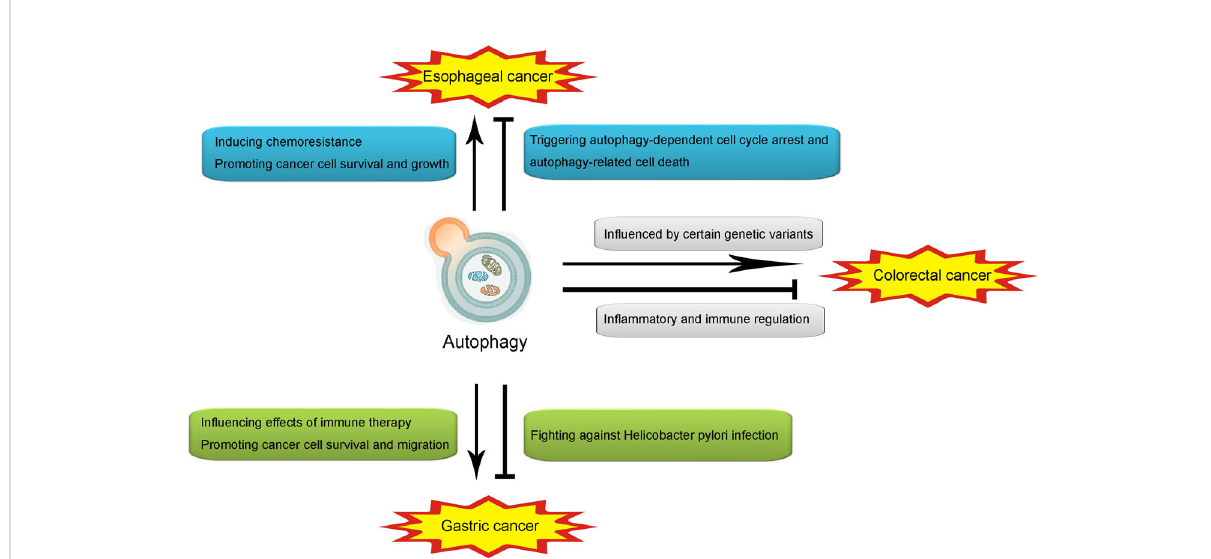
FIGURE 2 Illustration of the role of autophagy in esophageal cancer, gastric cancer and colorectal cancer. Autophagy may promote esophageal cancer through inducing chemoresistance and promoting cancer cell survival and growth. However, autophagy may also attenuate esophageal cancer through triggering autophagy-dependent cell cycle arrest and autophagy-related cell death. In gastric cancer, autophagy may promote the onset and development through in fl uencing effects of immune therapy. However, autophagy may also attenuate it through fi ghting against Helicobacter pylori infection. In colorectal cancer, autophagy may promote the pathogenesis and progression through the in fl uence of certain genetic variants in autophagy, while producing an attenuative effect through in fl ammatory and immune